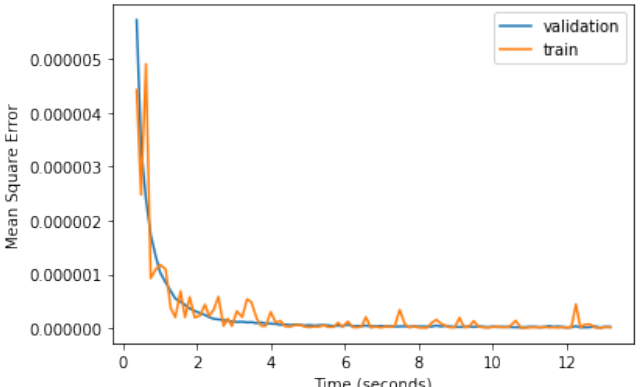
Figure 10. MSE convergence for training and validation data in the DNN